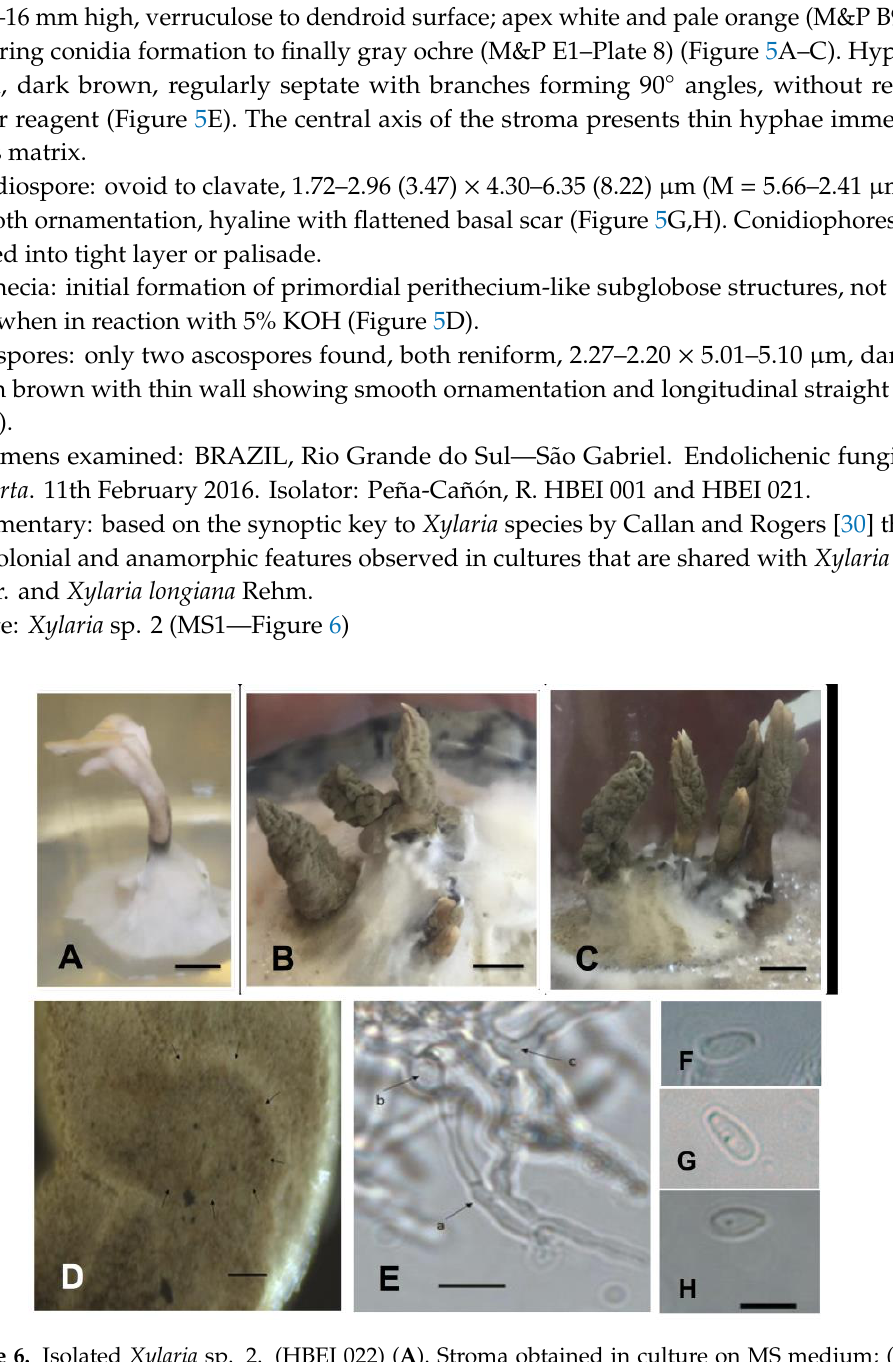
Figure 6. Isolated Xylaria sp. 2. (HBEI 022) ( A ). Stroma obtained in culture on MS medium; ( B , C ). Stromata on MEA 2% medium; ( D ). Initial formation of the perithecium (arrows); ( E ). Bright-field microscopy. Hyphae of hypothecium with anastomose (arrow a) and basal (arrow b) and irregular hyphae (arrow c). ( D , F – H ). Differential interference contrast microscopy (DIC); ( F – H ). Conidiospore.—Scale bars ( A – C ) = 4 mm, ( D – H ) = 10 µm.